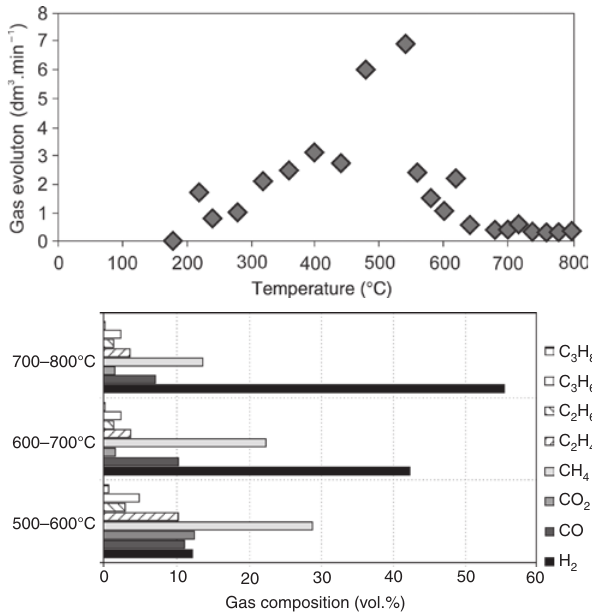
Figure 3: Gas evolution and composition.